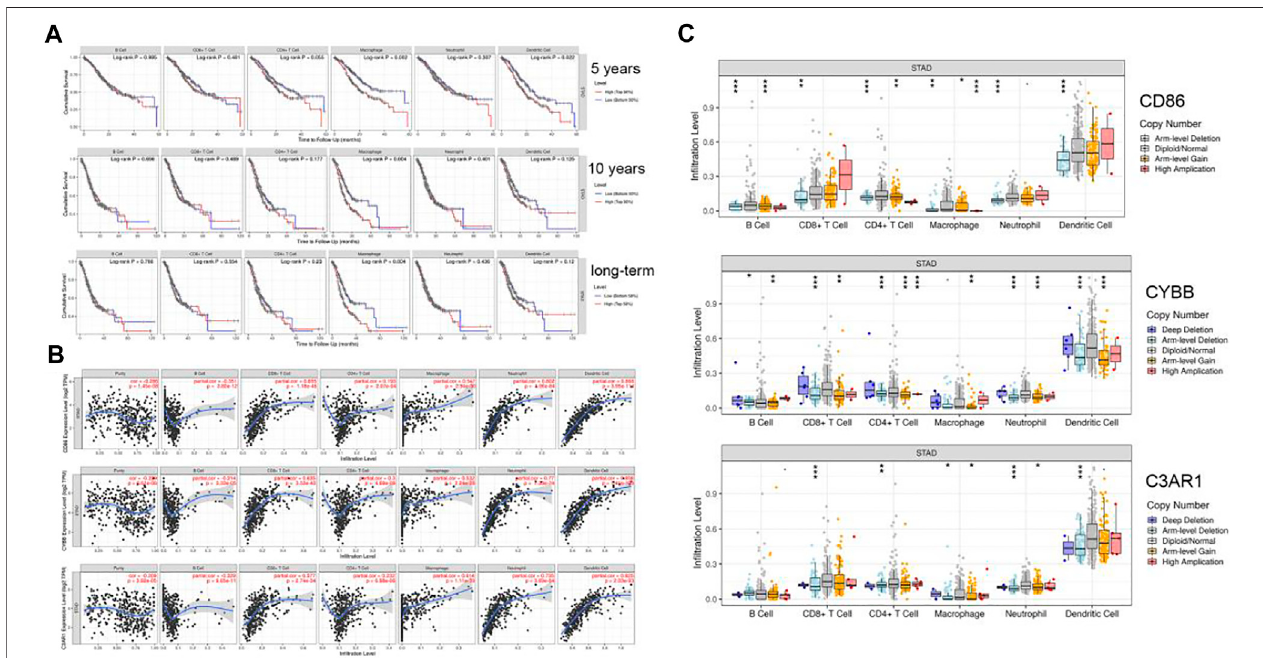
FIGURE7| Sixkindsofimmune cellsin fi ltration situation inTIMER. (A) TheeffectofCD86,CYBB, C3AR1 expressionon sixkindsofimmune cells. (B) Thesurvival of immune cells. (C) Mutations in fl uence the immune in fi ltration (* p < 0.05, ** p < 0.01, *** p < 0.001).